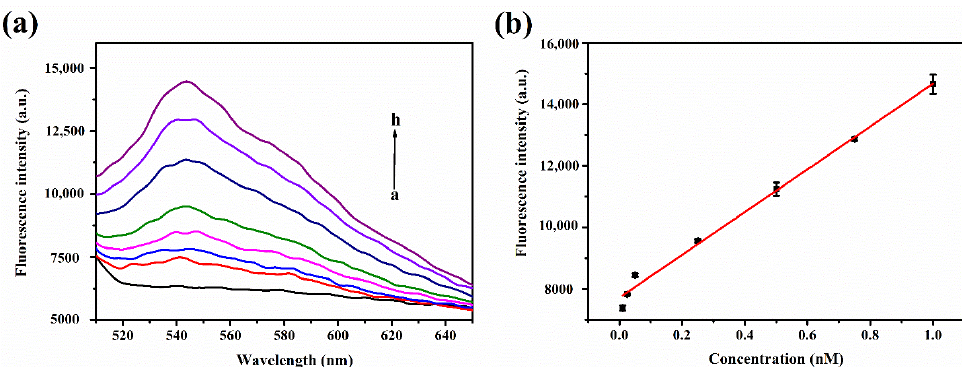
Figure 3 . Performance of the biosensor as determined by fluorescence recovery in the presence of target miRNA ( a ) Fluorescence emission spectra of the dsDNA-AuNPs probe in response to various concentrations of the target miRNA let-7a. From a–h: 0, 0.01, 0.025, 0.05, 0.25, 0.5, 0.75, and 1 nM (excitation: 488 nm, emission: 543 nm). ( b ) Calibration curve showing the linear relationship between let-7a concentration and fluorescence intensity.